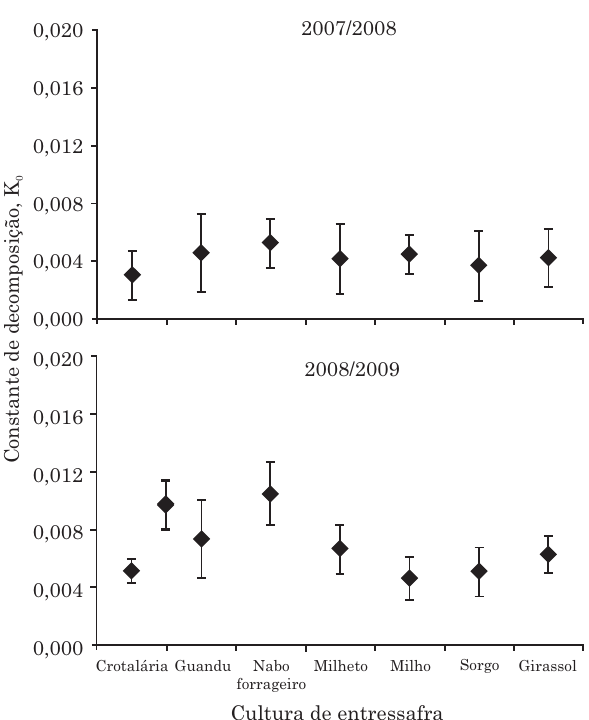
Figura 3. Constantes (K 0 ) das equações exponenciais simples (y = A 0 .e -K0.t ) ajustadas para a decomposição dos resíduos das culturas de entressafra. As barras verticais representam o intervalo de confiança do parâmetro K 0 a 5 %.